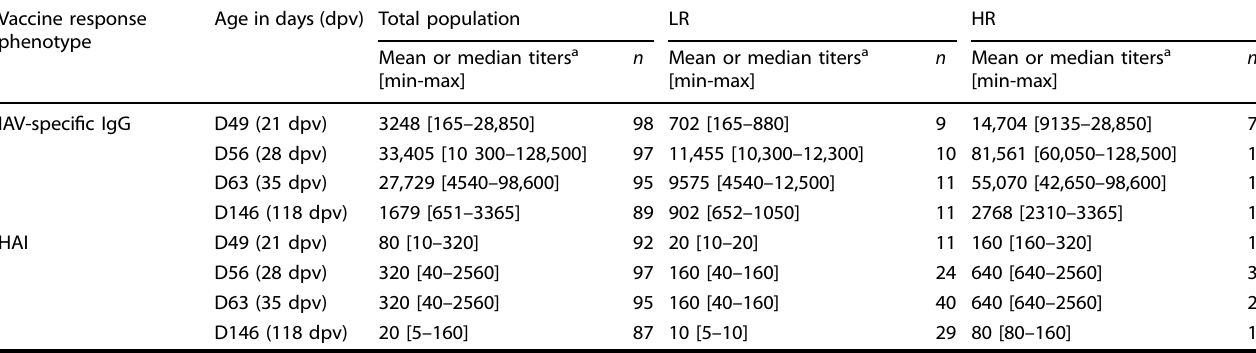
Table 1. Average vaccine response at four time points